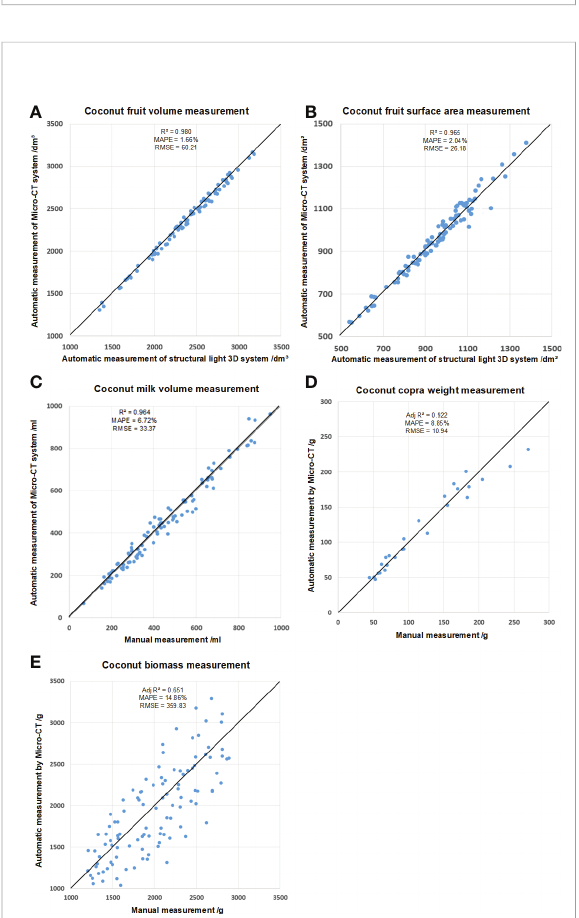
FIGURE 9 Mesurement of (A) coconut fruit total volume, (B) total surface area, (C) milk volume, (D) copra weight, and (E)